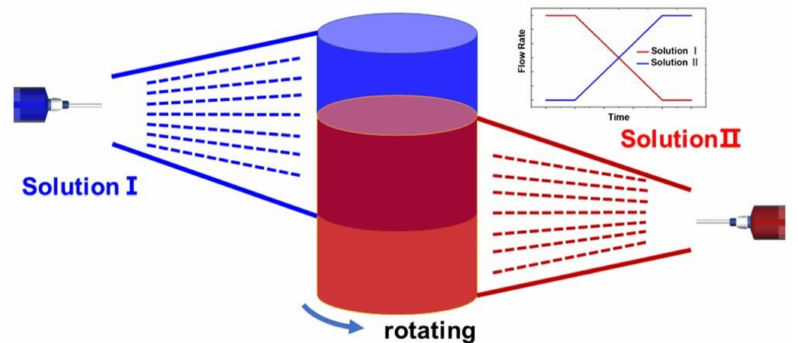
Figure 3. Preparation of multifunctional scaffolds via controlling the speed of electrospinning solution during co-spinning progress. Reproduced with permission [45]. © 2021 Wiley-VCH GmbH.